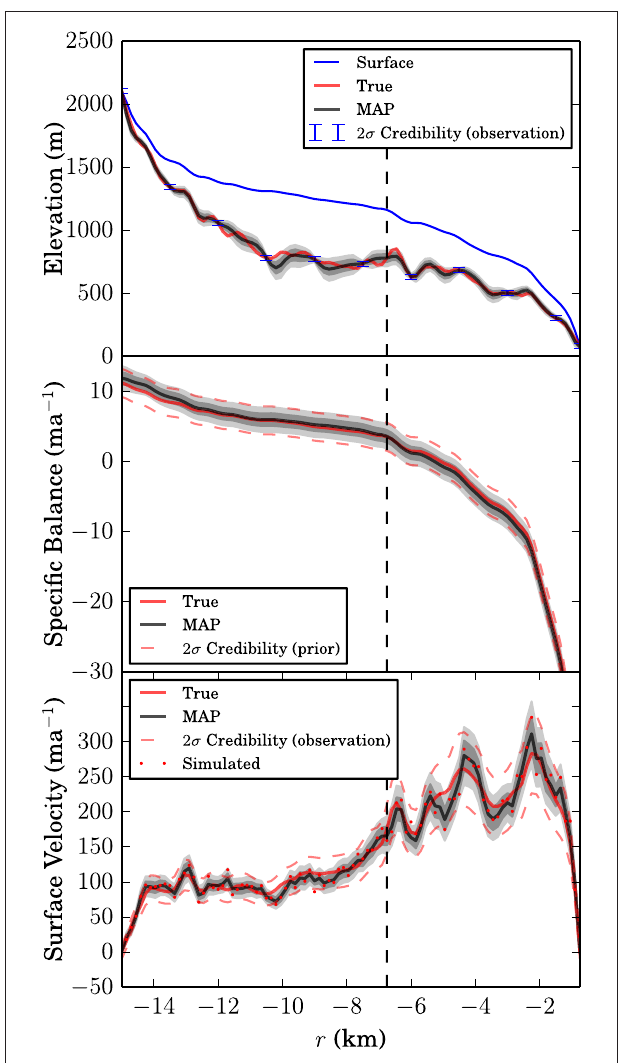
FIGURE 1 | Recovered pointwise probability densities for a synthetic glacier. Dark and light gray shaded regions indicate the σ and 2 σ posterior credibility interval respectively, and MAP refers to the solution corresponding to the maximum a posteriori probability. The dashed vertical line is the location at which the histograms in Figure 2 are